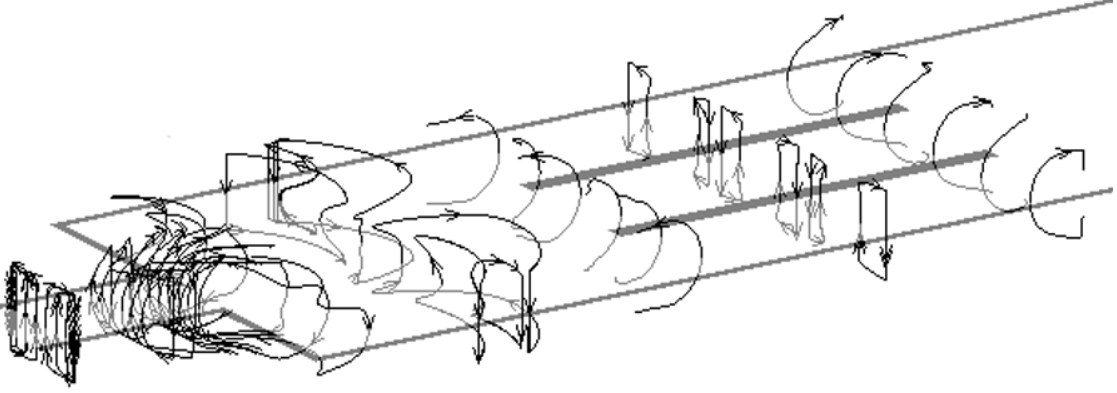
Figure 13. Example of induced 3D electric currents in the flow with sudden expansion computed in [62] at Ha = 1465 and Re = 50. The liquid moves from left to right. The magnetic field is in the transverse direction along the longest duct wall. Near the inlet inside the small duct, and also at the exit inside the larger duct, the currents are 2D. The 3D current circuits are clearly seen right upstream and downstream of the expansion.